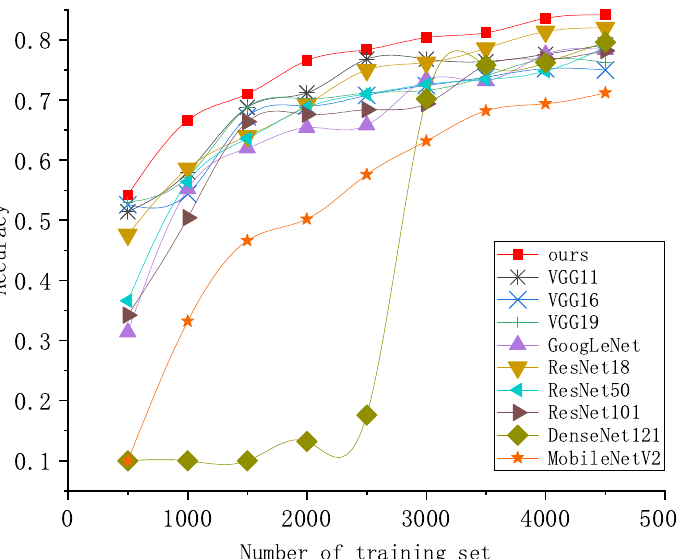
Figure 7. With the decrease of the number of training sets, the accuracy of each network in the verification set (500 pieces) is improved.